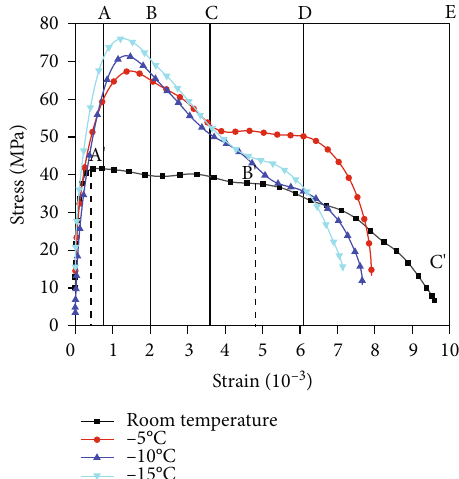
Figure 4: Dynamic stress-strain curve of frozen concrete elements (saturated).